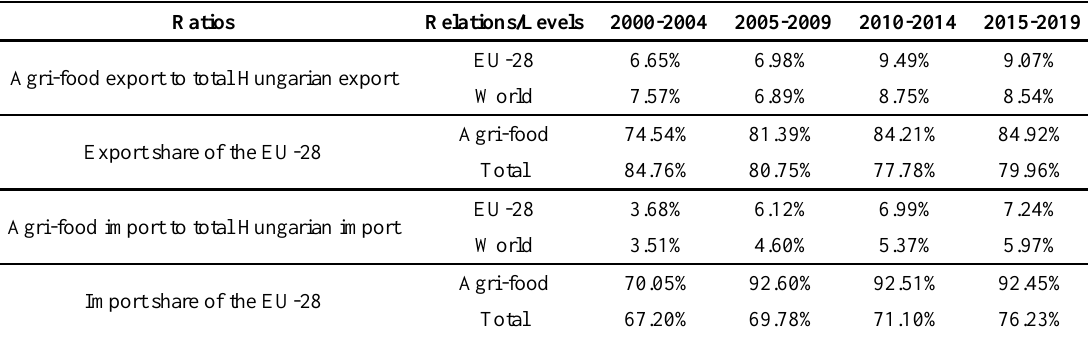
Table 3. Importance of the agri-food imports and exports on world and EU-28 levels